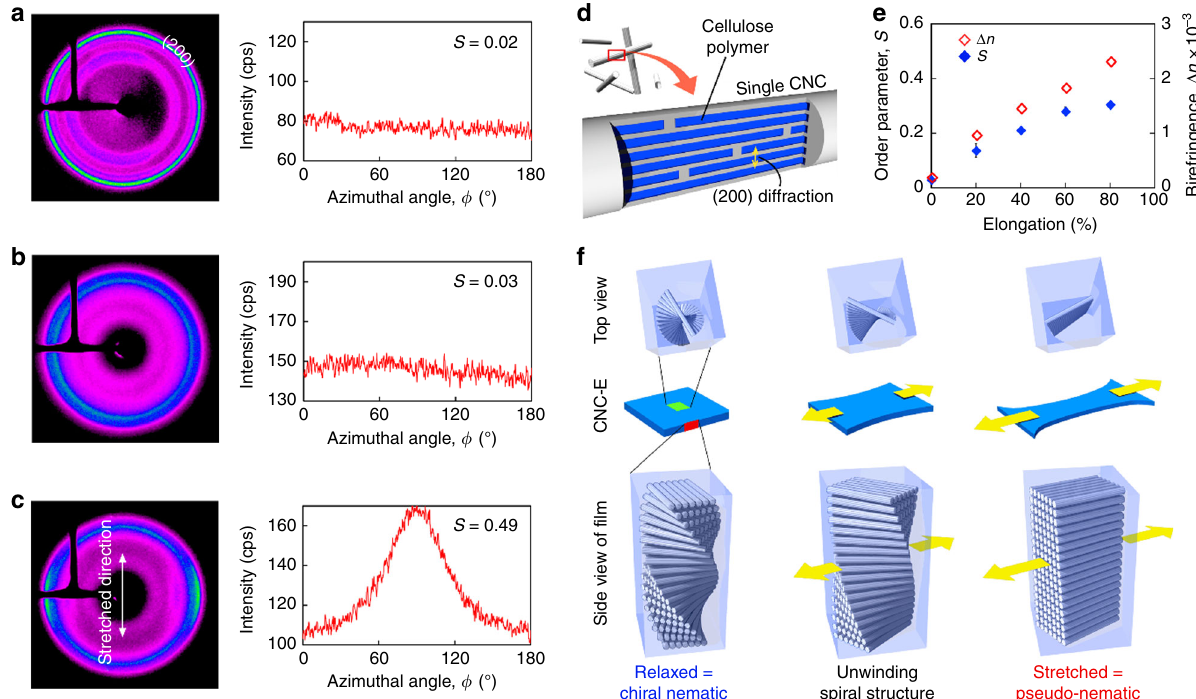
Fig. 4 Two-dimensional X-ray diffraction analysis. a Diffraction pattern and intensity at 2 θ = 22.9° of G-CNC, b unstretched CNC-E, and c stretched CNC-E (250% elongation). (The value in the plots is the calculated order parameter, S ). d Schematic of idealized cross section of a single CNC nanocrystal, where the blue square represents a single cellulose polymer chain that is aligned with the CNC rod axis. X-ray diffraction of the (200) plane can be found at 2 θ = 22.9°. e Plot of order parameter S and birefringence Δ n relative to elongation ratio. Error bars represent s.d. of two measurements. f Schematic illustration of reorientation of CNCs from chiral nematic to a pseudo-nematic structure as the sample is